Question: What type of chart is this?
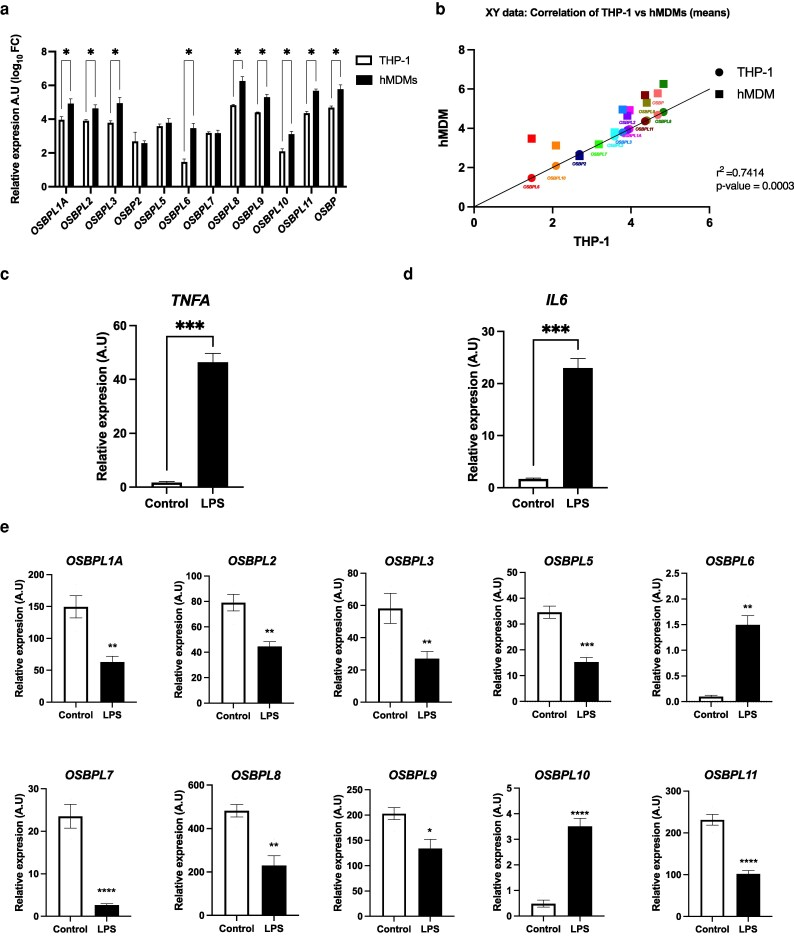
Answer: bar